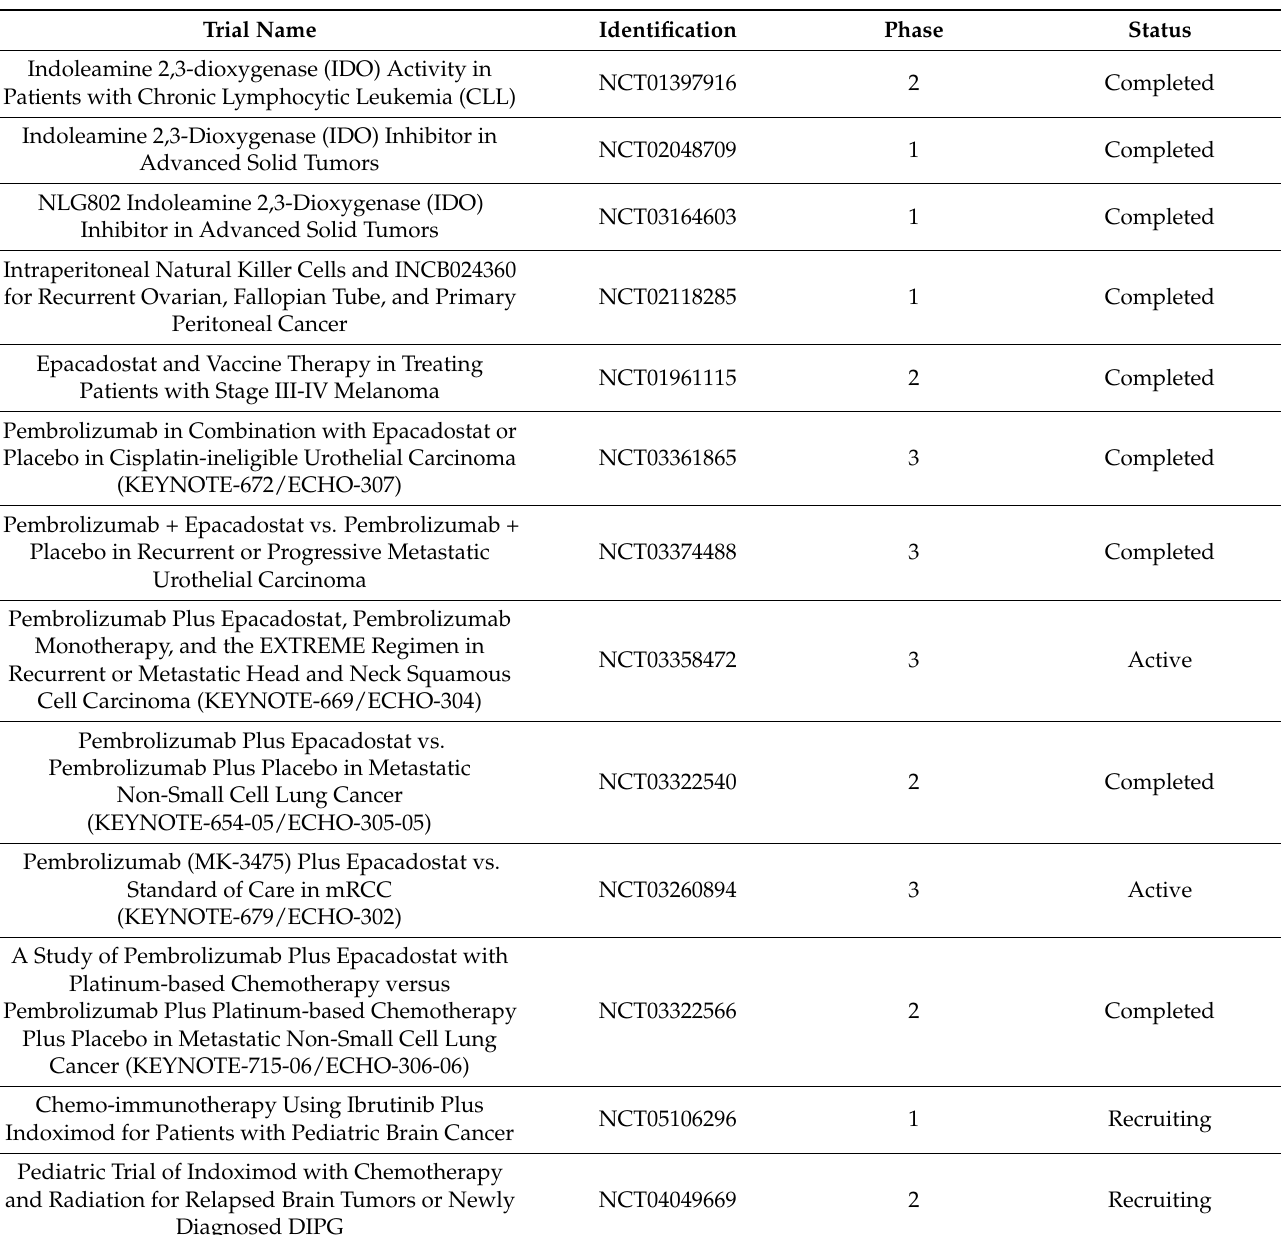
Table 1. Clinical trials evaluating IDO1 inhibitors in